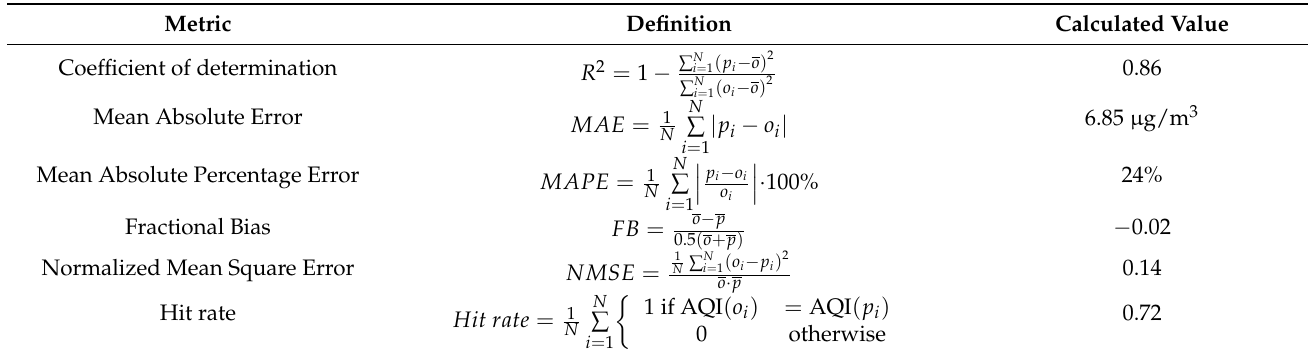
Table 8. Validation metrics and their values calculated for the model outputs ( o i and p i are concentrations observed and predicted by the model for the i -th h, respectively; o and p are the mean values). Metric Definition Calculated